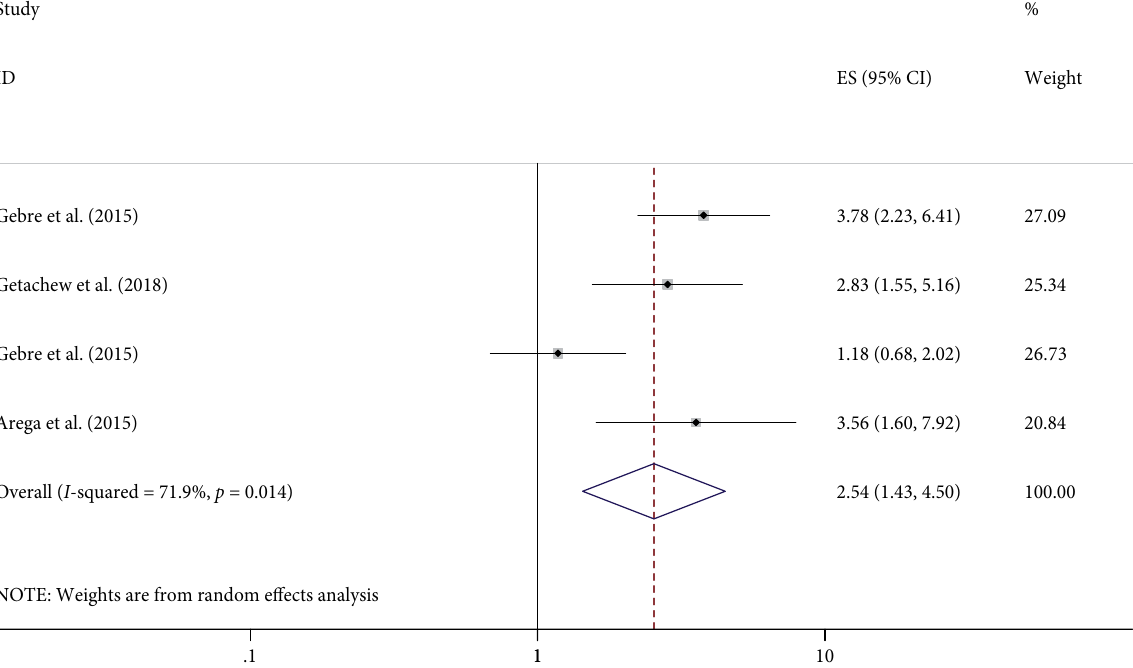
Figure 5: The relationship between the number of ANC visit and compliance with iron-folic acid supplementation in Ethiopia,